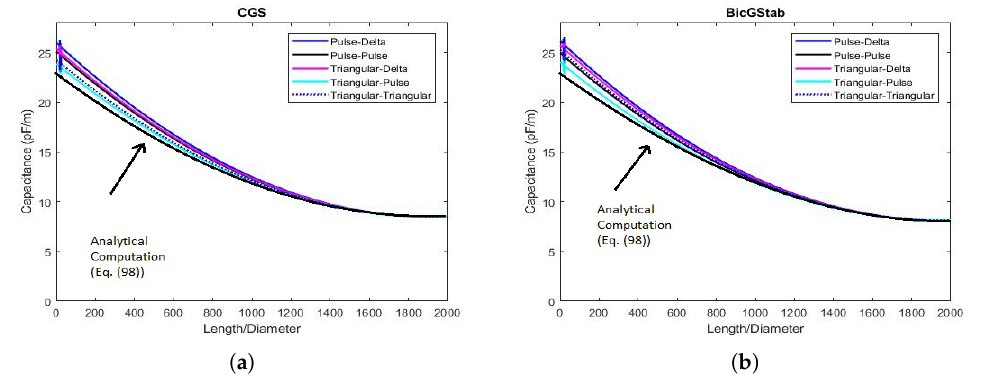
Figure 4. C vs. L / d ratio for each basis-testing functions with the ( a ) CGS algorithm and ( b ) BicGStab